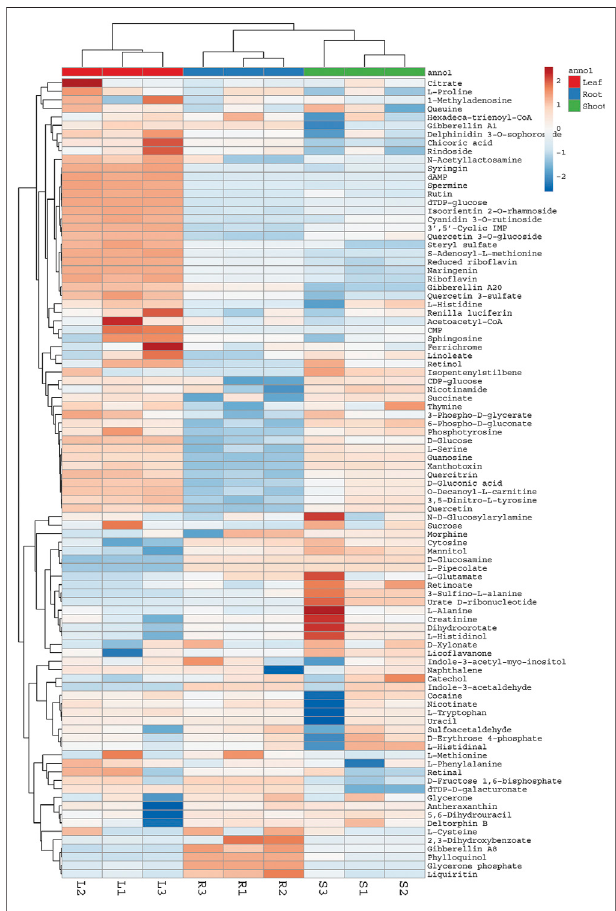
FIGURE 3 | Heat map showing relative abundance of different compounds detected in aerial parts and roots of G. uralensis . Heat map was